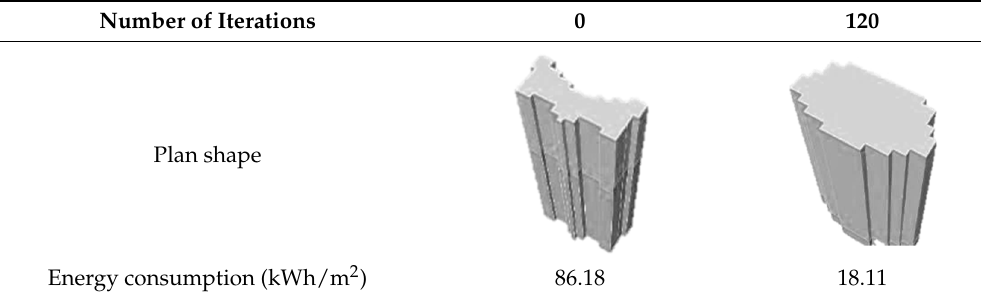
Table 5. Model comparison before and after optimization.